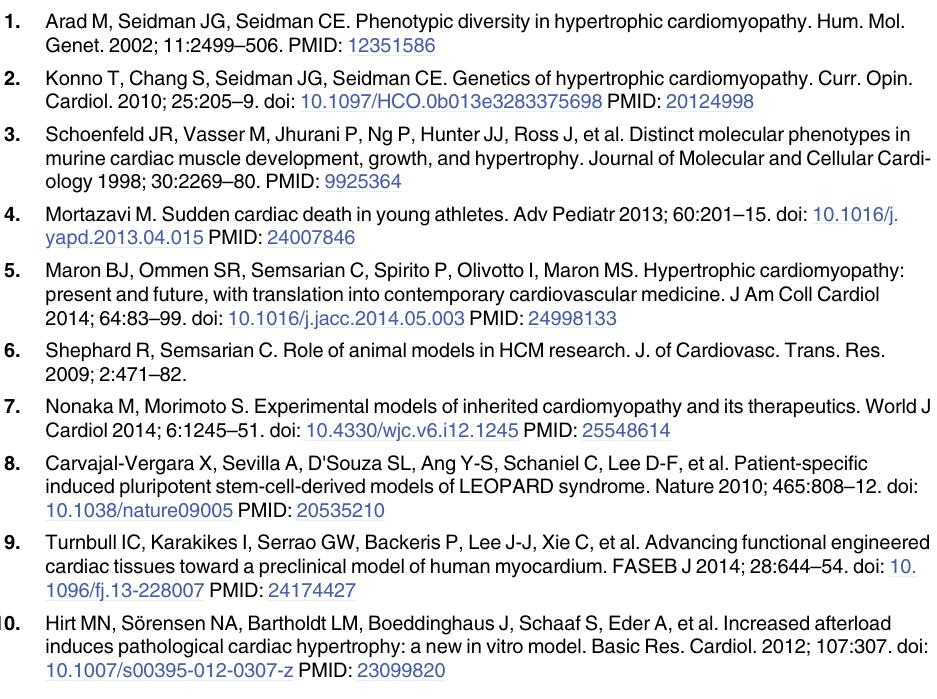
mutant (bottom) at both day 6 (left) and day 11 (right) of pacing from 1 – 2.5 Hz; ( B ) Force-fre- quency relationship of hiPSC-hECT diastolic force relative to the diastolic force at 1 Hz at both day 6 (left) and day 11 (right); (C) Force-frequency relationship of hiPSC-derived hECT sys- tolic force relative to the starting systolic force at 1 Hz at both day 6 (left) and day 11 (right). At both day 6 and day 11, the change in diastolic force versus frequency for the mutant is much less than that of the wild-type. Error bars represent standard error. (cid:1) p < 0.05, (cid:1)(cid:1) p < 0.01 between mutant and wild-type relative forces. S1 Table. Orthogonal principal component coefficients on day 6 of experimentation. S2 Table. Orthogonal principal component coefficients on day 11 of